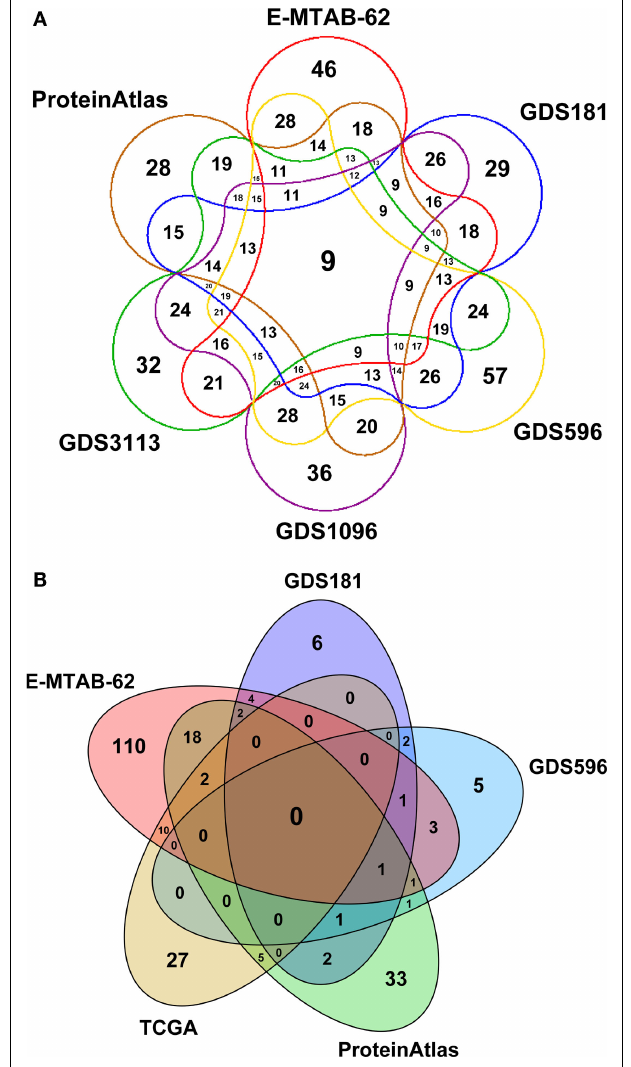
FIGURE 3 | Venn diagrams depicting: (A) the number of common tissues and (B) the number of common cancer types across expression datasets in SPECTRA . The zero overlap among the cancer datasets is due to the fact that cancers are considered according to their specific names and not to their class (breast cancer, prostate cancer,